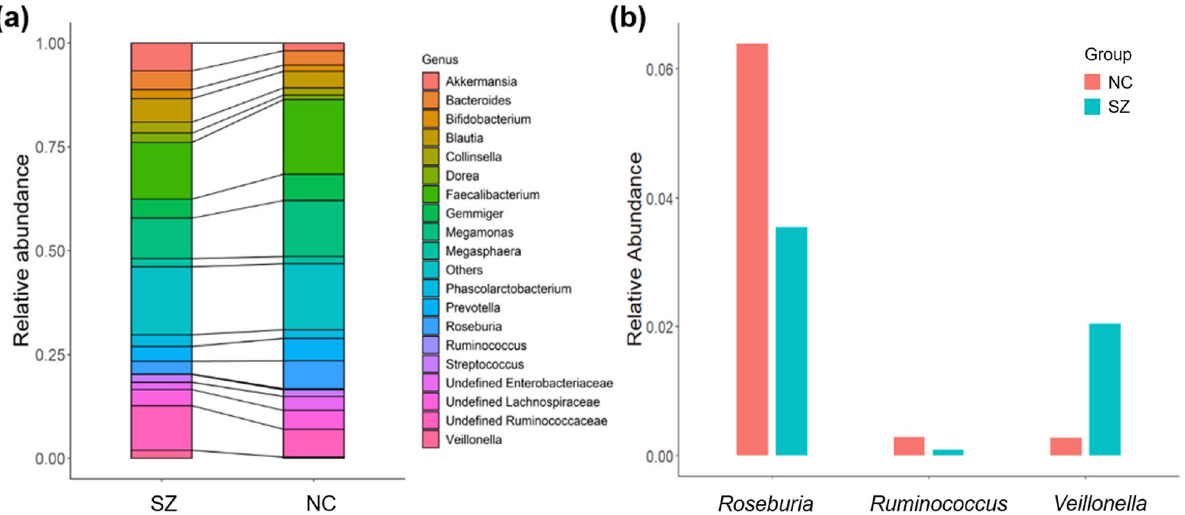
Figure 2. Microbial composition at the genus level. ( a ) Summary of the most abundant genera in the NC and SZ groups. ( b ) Bacterial genera that were significantly different between the two groups ( p < 0.05,